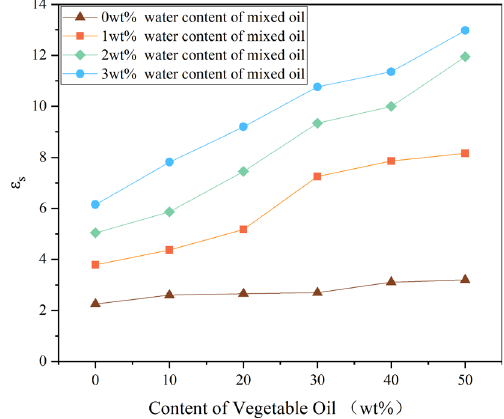
Figure 7. Dielectric constant of mixed oil models.